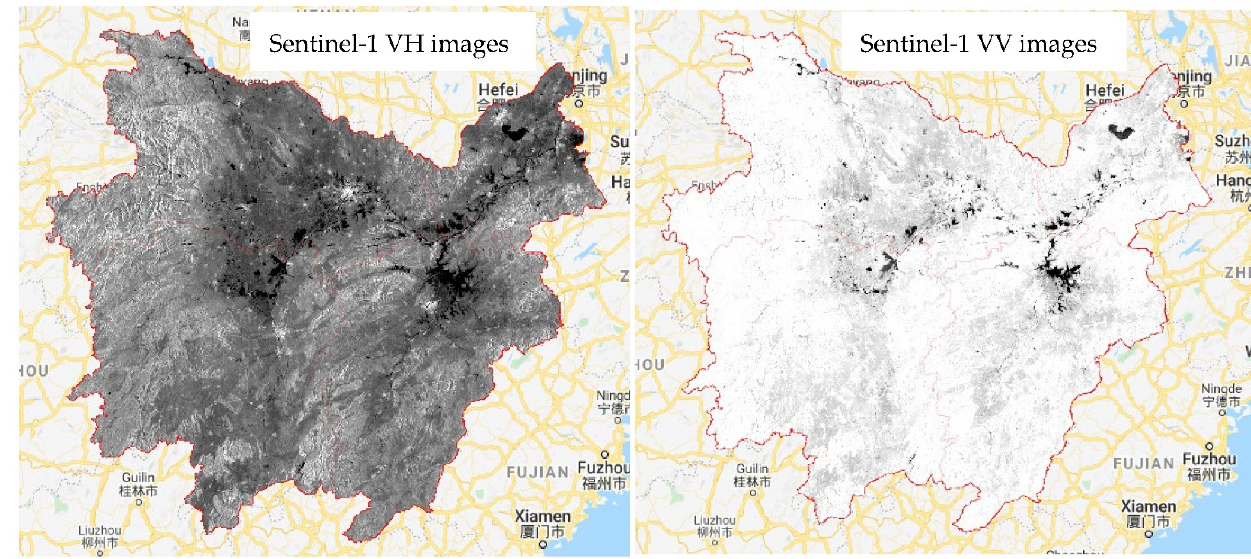
Figure 3. Study area covered by Sentinel-1 images.